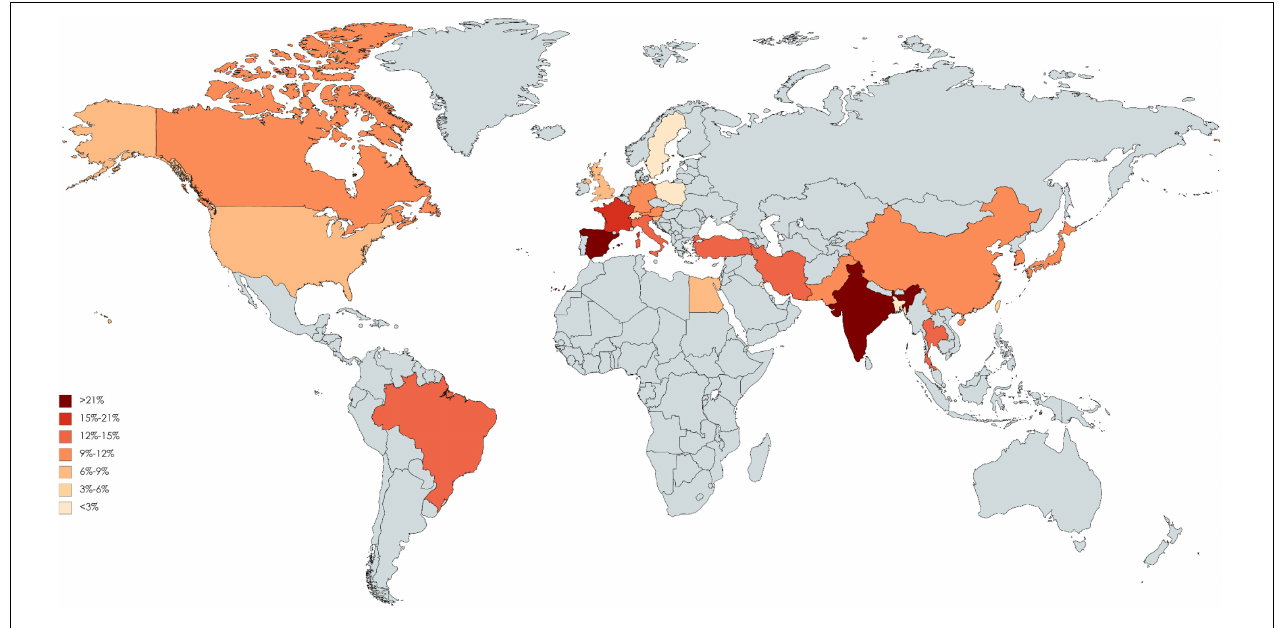
FIGURE 3 | Global incidence proportion of acute kidney injury after angiography.